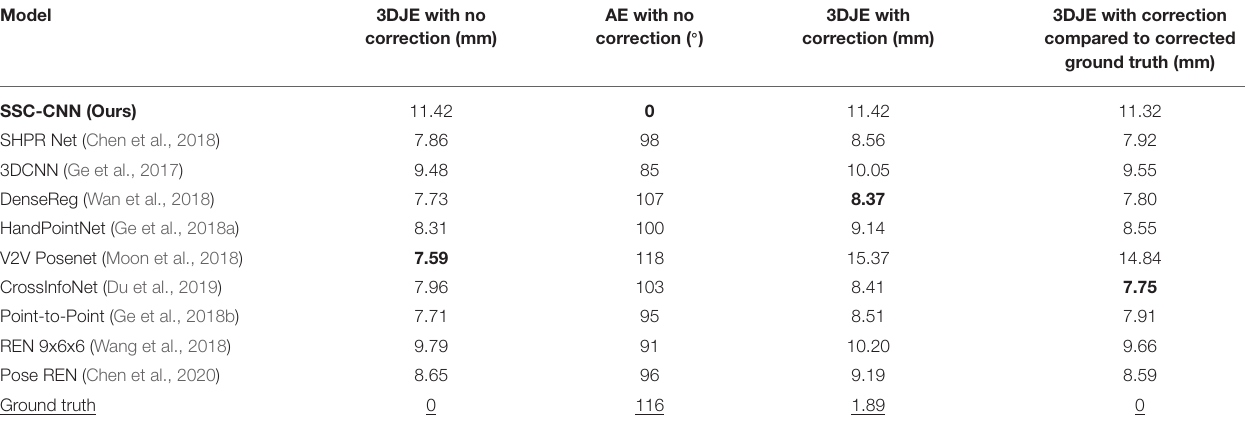
TABLE 3 | 3D Joint Errors (3DJE) and Anatomical Errors (AE) derived from 20,000 images from the MSRA dataset with all the models. Model 3DJE with no